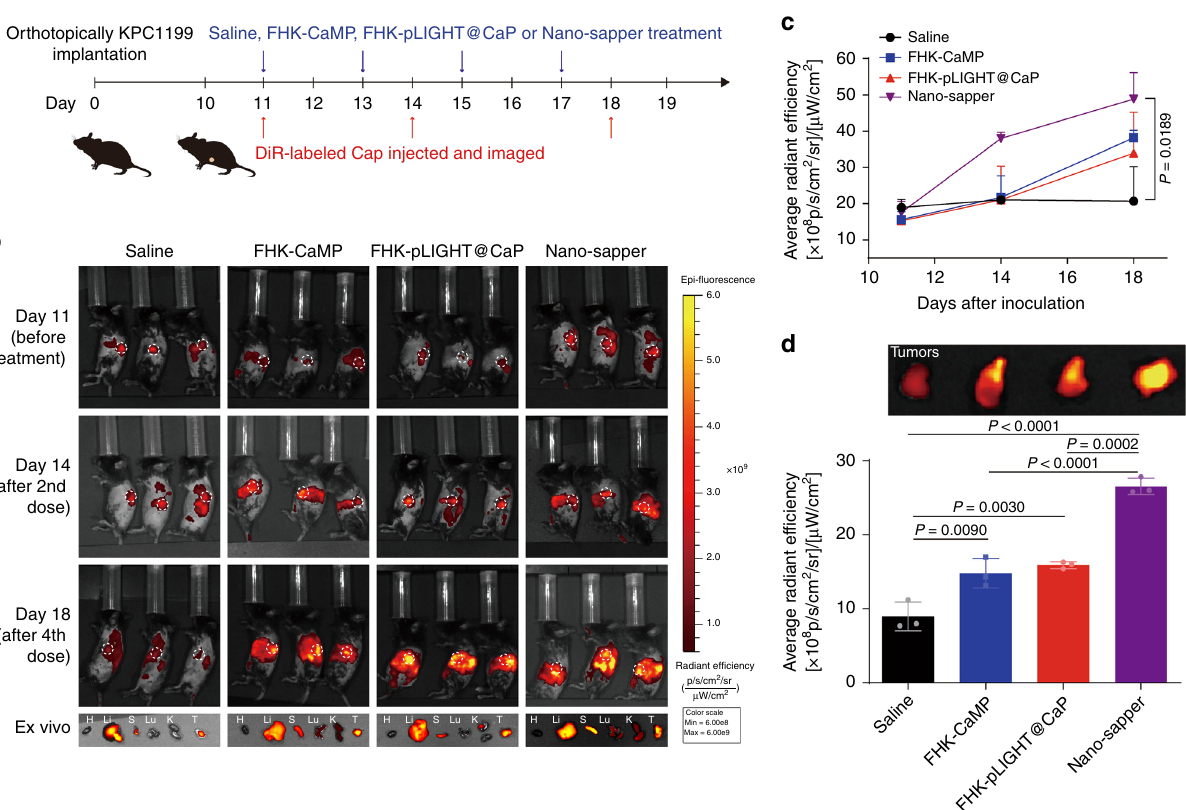
Fig. 5 Nano-sapper exhibited self-enhanced accumulation in PDAC. a Six-week-old male C57BL/6 mice were orthotopically inoculated with KPC1199 cells (1 × 10 6 ) on day 0. Saline, FHK-CaMP (MP = 13.9 mg/kg), FHK-pLIGHT@CaP (25 μ g plasmid per mouse) and Nano-sapper (MP = 13.9 mg/kg, 25 μ g plasmid per mouse) were i.v. administered on day 11, 13, 15, and 17, and DiR-labeled CaP was i.v. administered on day 11, 14, and 18 (DiR = 1 mg/kg), and subjected to IVIS TM for in vivo imaging. On day 18, tumors were harvested for ex vivo detection. b , c DiR signal was monitored to re fl ect the accumulation of CaP. H, heart; Li, liver; S, spleen; Lu, lung; K, kidney ( n = 3 mice). d Tumors were extracted to detect DiR signal ( n = 3 mice). Data are presented as mean ± s.d. One-way ANOVA with Bonferroni multiple comparisons post-test was used for ( c ) and ( d ). Error bars represent s.d. Source data of ( c ) are provided as a Source Data fi